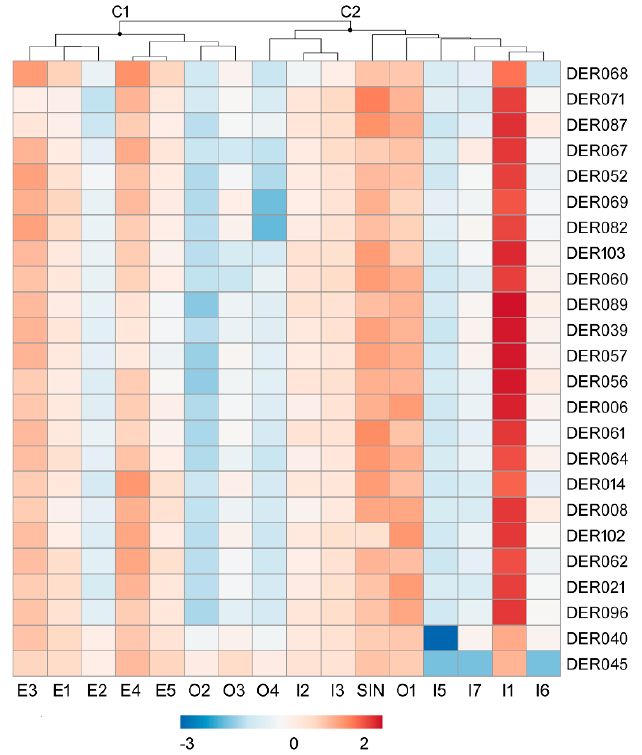
Figure 3. Hierarchical Cluster Analysis for the identified volatile compounds and content in sinigrin in the 24 populations of wall rocket. Data represent the average value for each population ( n = 3). For compound identities refer to Table 3.